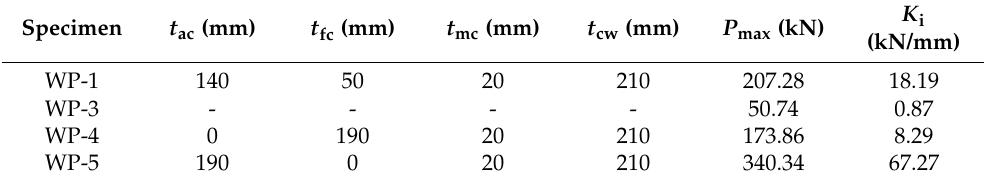
Table 6. Design parameters of the FE